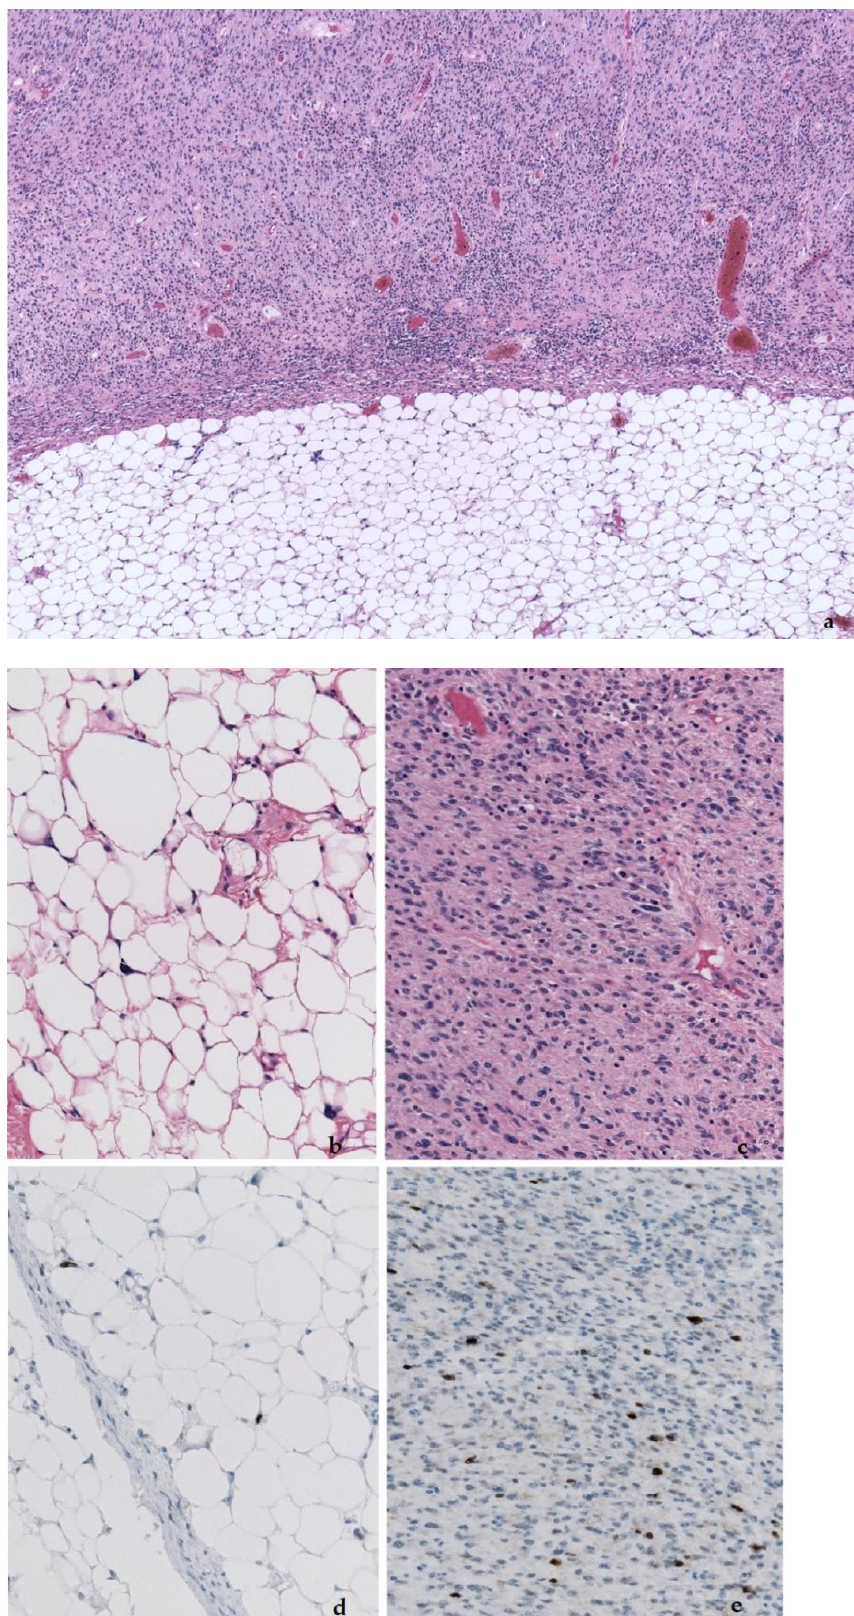
Figure 7. Abrupt transition of the well-differentiated lipoma-like liposarcoma part to the non-lipogenic sarcomatous part ( a ). Detail of both parts ( b , c ), and MDM2 expression in both parts ( d , e ).